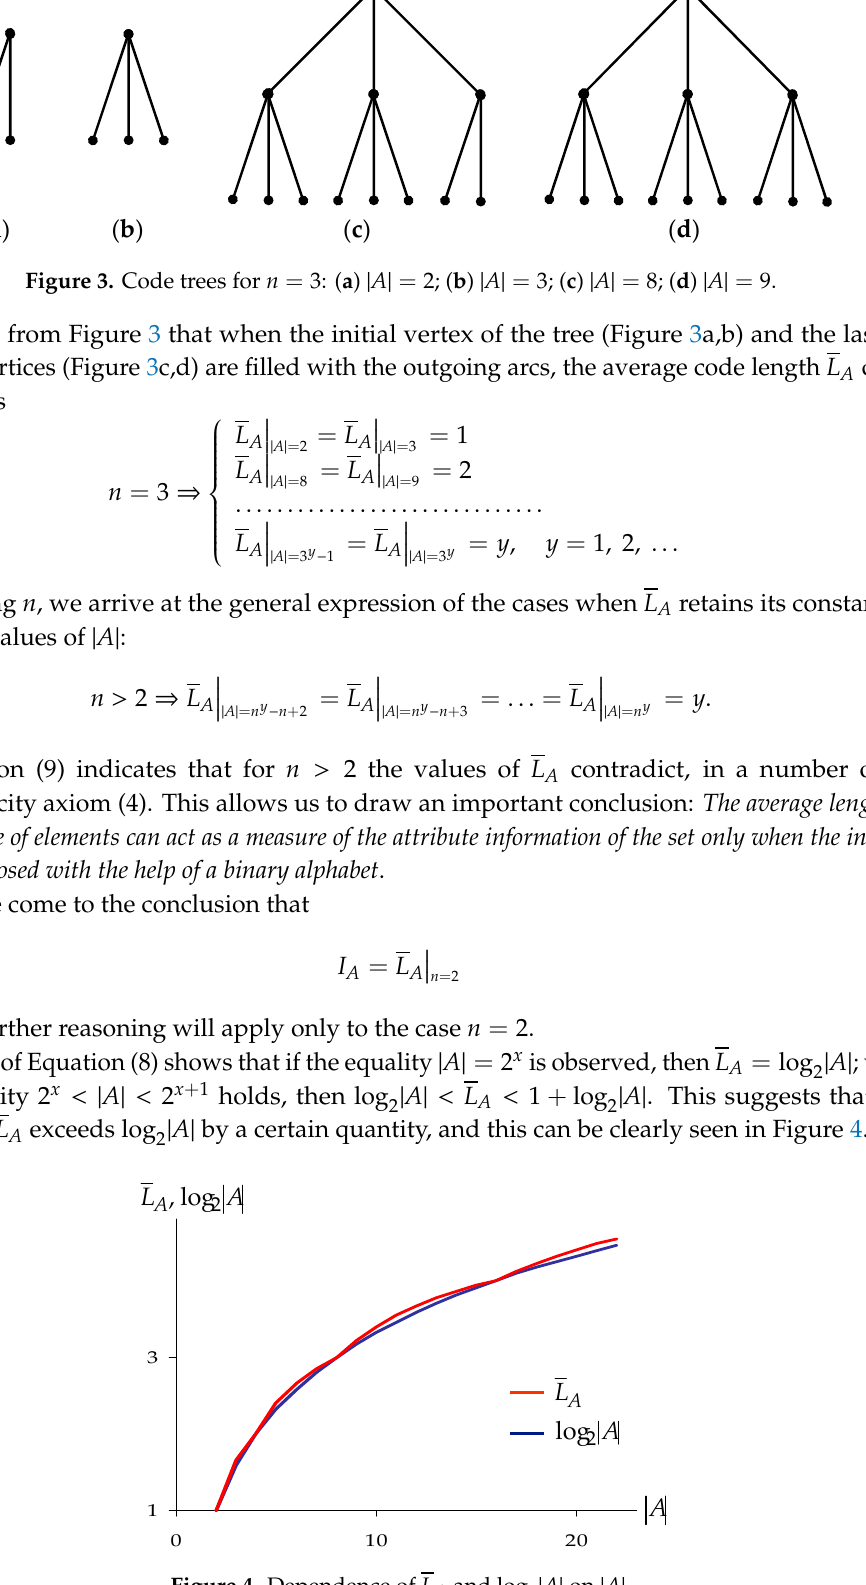
Figure 4. Dependence of L A and log